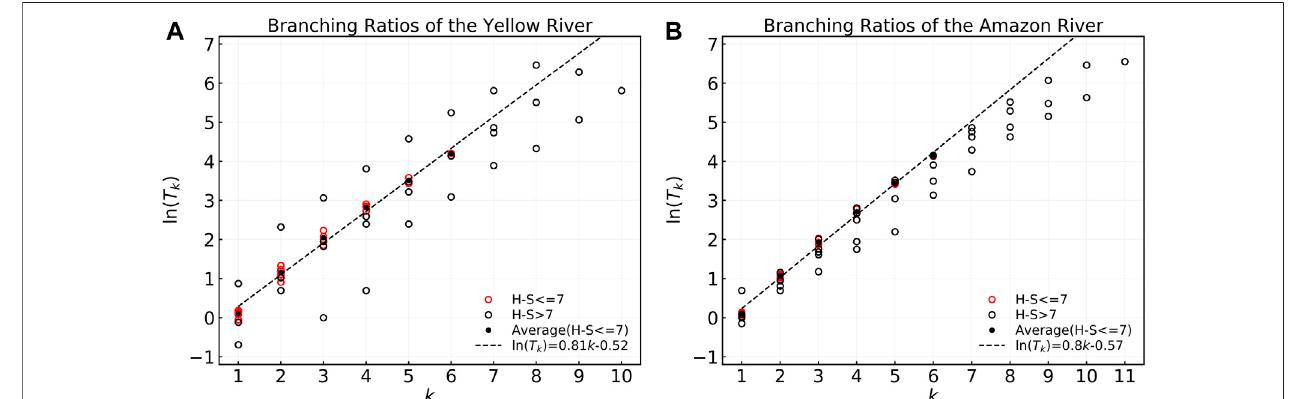
FIGURE 11 | Branching ratios, T k , of the Yellow River and theAmazon River for every k . The black circles are the branching ratios shown in the shaded sections of thematricesof SupplementaryTableS2 .Theredcirclesaretheremainingdatainthematrices.Theblackpointsaretheaveragevaluesoftheblackcircles.Thedotted black line is the fi t of the black points using the least squares regression